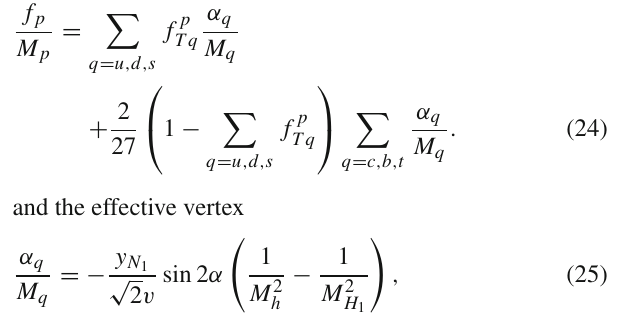
Fig. 6 Spin-independent cross section as a function of M N solid and dashed line correspond to current XENON1T [78] and future LZ [79] limits, respectively. In this figure, we have set M H and v